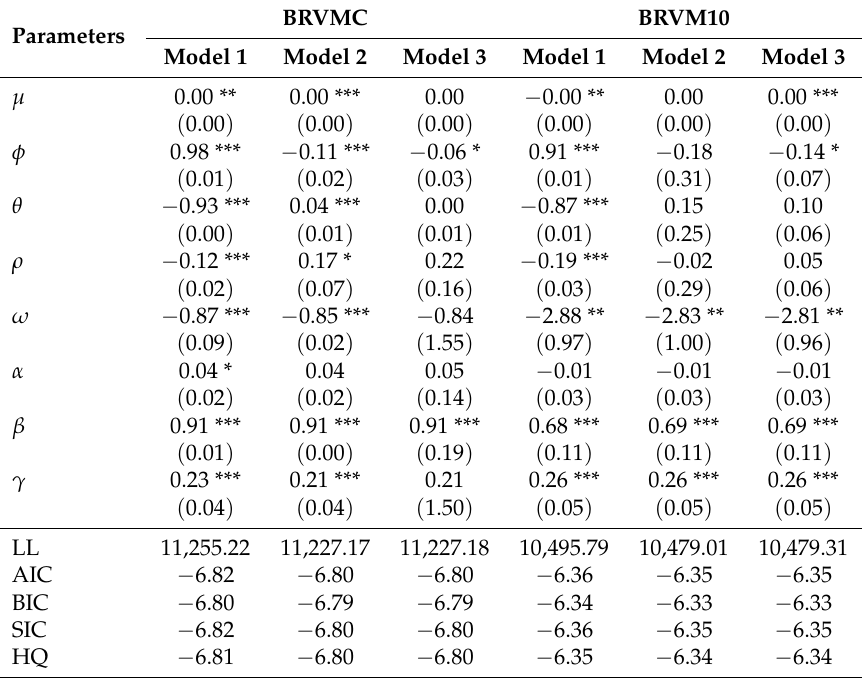
Table 5. Models with two and three consecutive price